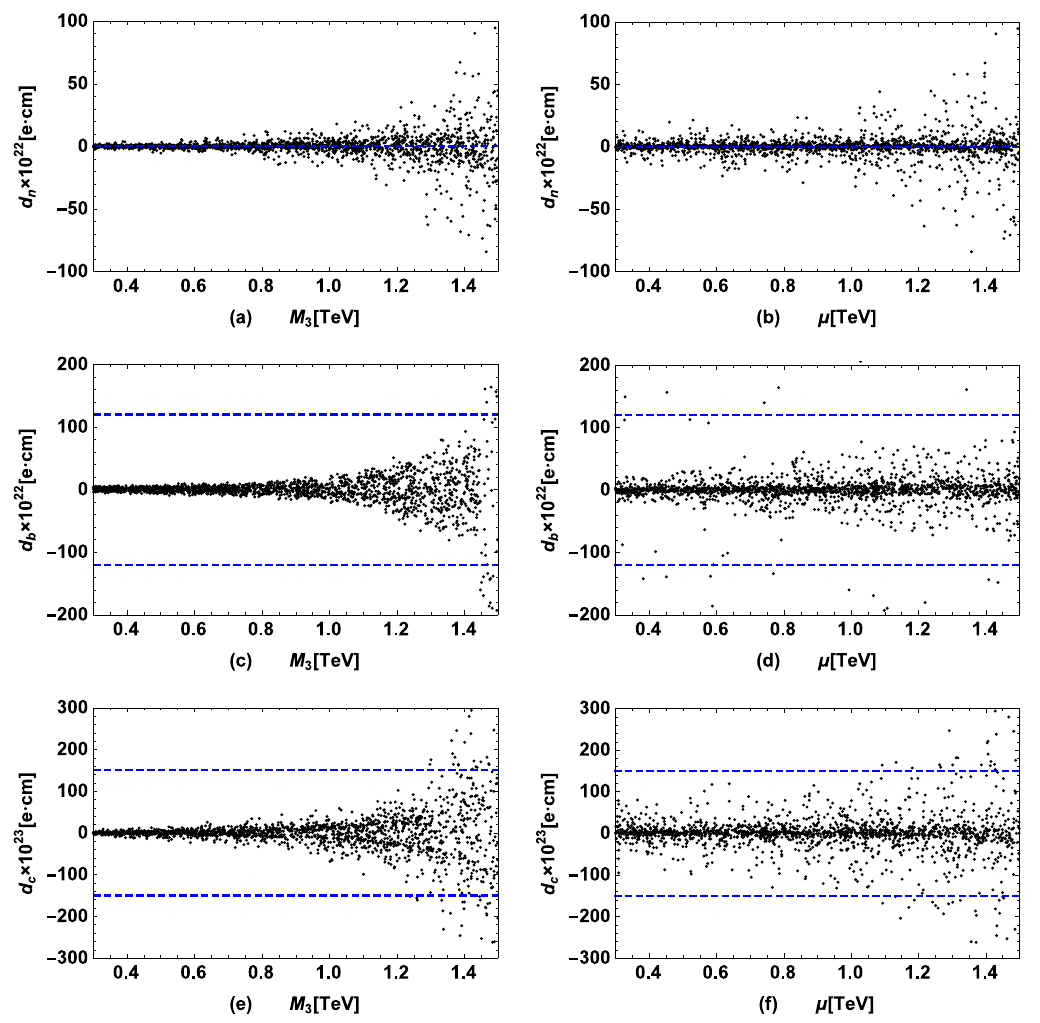
Figure 6 . Scanning the parameter space shown in eq. (4.1), d n , d b and d c versus M 3 , (cid:22) are plotted, where the blue dashed lines denote the corresponding upper